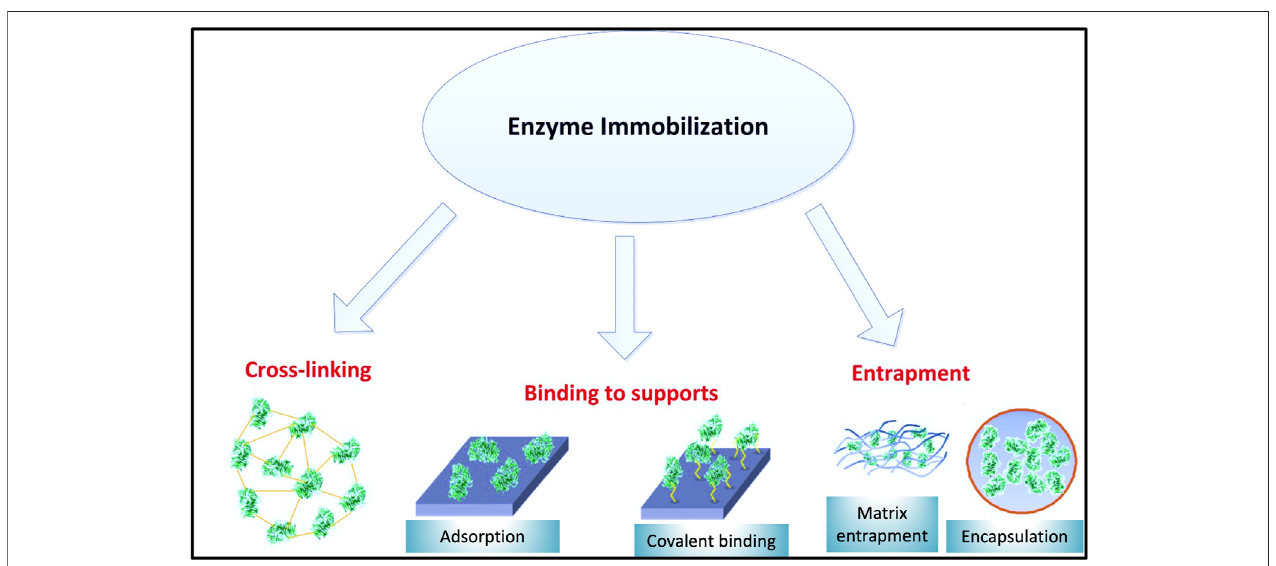
FIGURE 4 | Enzyme immobilization